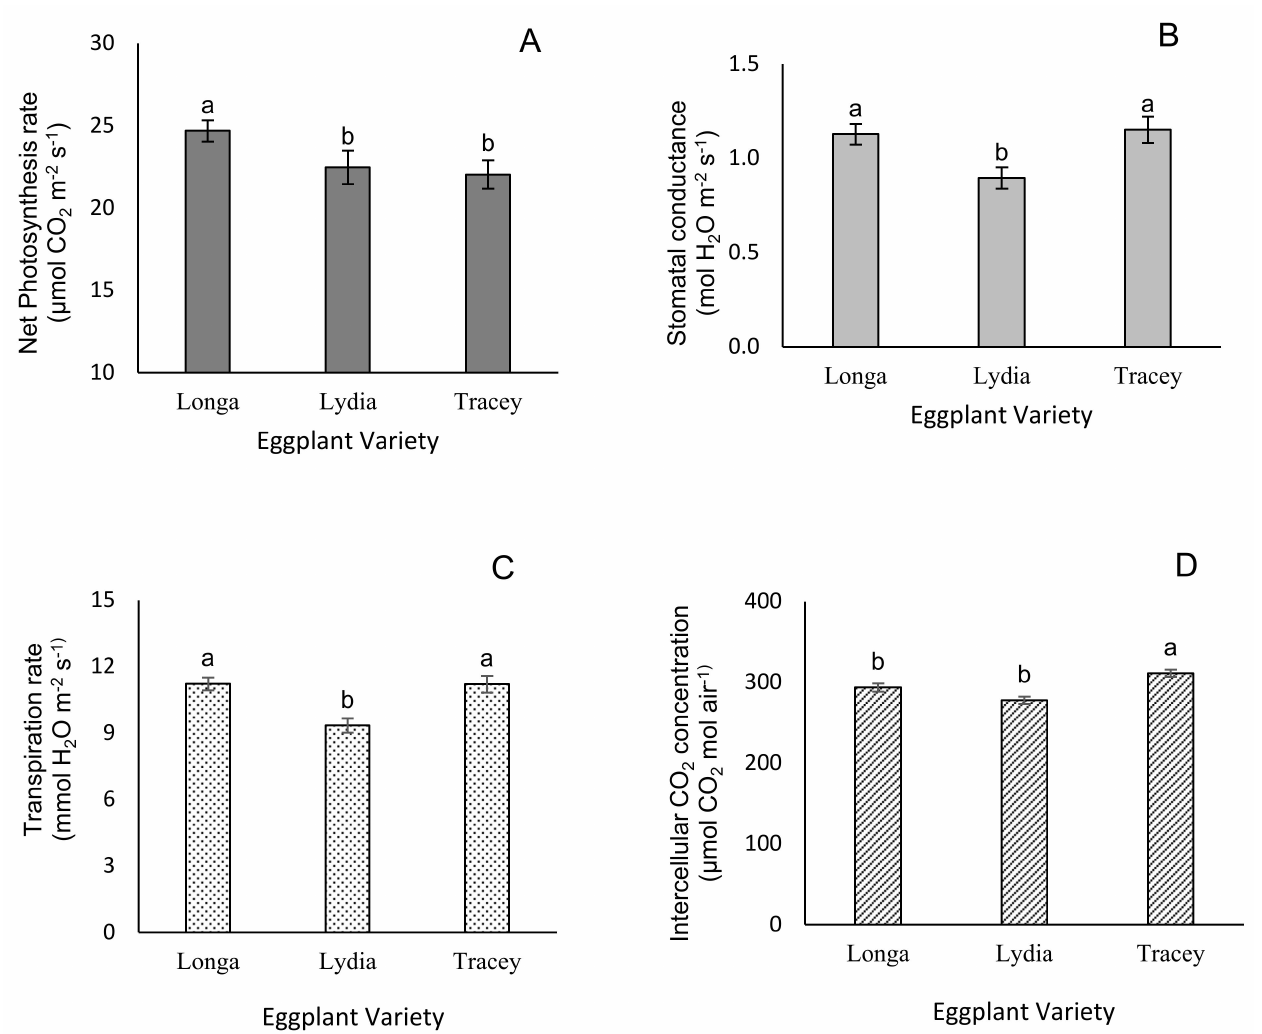
Figure 2. Average of leaf gas exchange parameters of eggplant in the high-tech greenhouse. Net Photosynthesis rate ( A ), stomatal conductance ( B ), Transpiration rate ( C ), and intercellular CO 2 concentration ( D ). Data are averaged over 6 weeks of measurements with 6 biological replicates for each cultivar per week. Different lowercase letters indicate statistical significance at p <